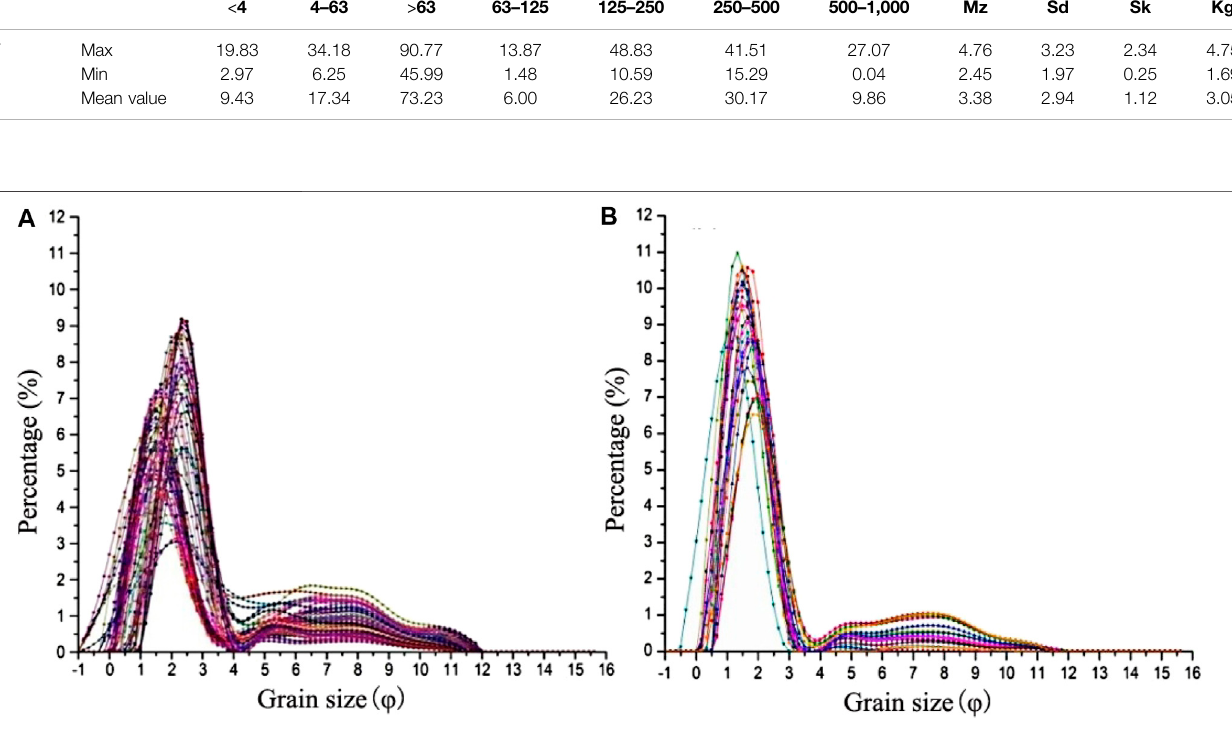
FIGURE 3 | The grain-size frequency curve of QF pro fi le (A) and ZS pro fi le (B) .